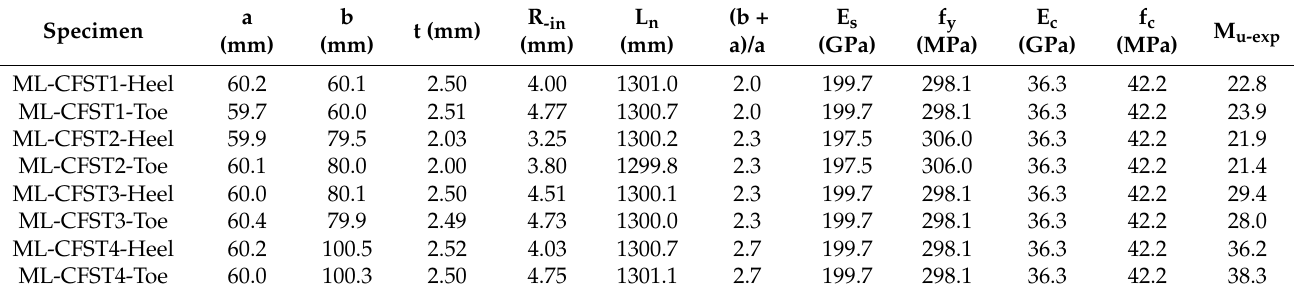
Table 1. Geometric and material properties of the test ML-CFST beams.